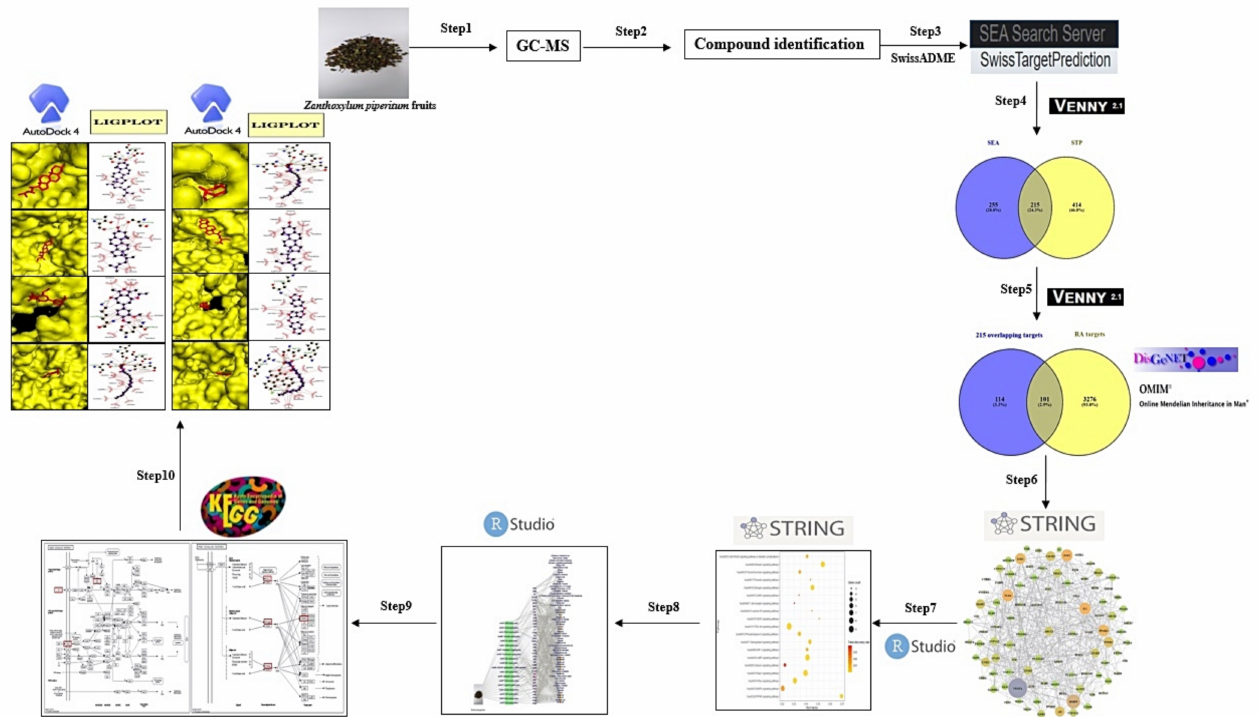
Figure 1. Workflow chart of network pharmacology analysis of ZPFs against